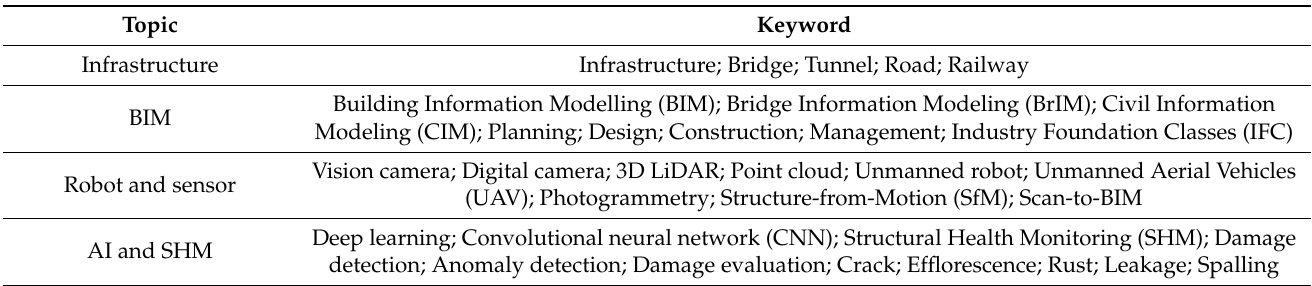
Table 1. Keywords for each topic.